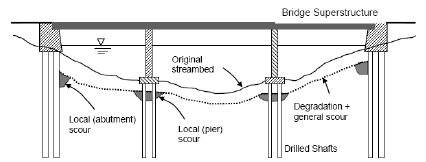
Figure 1. The scour around bridge supports (FHWA,